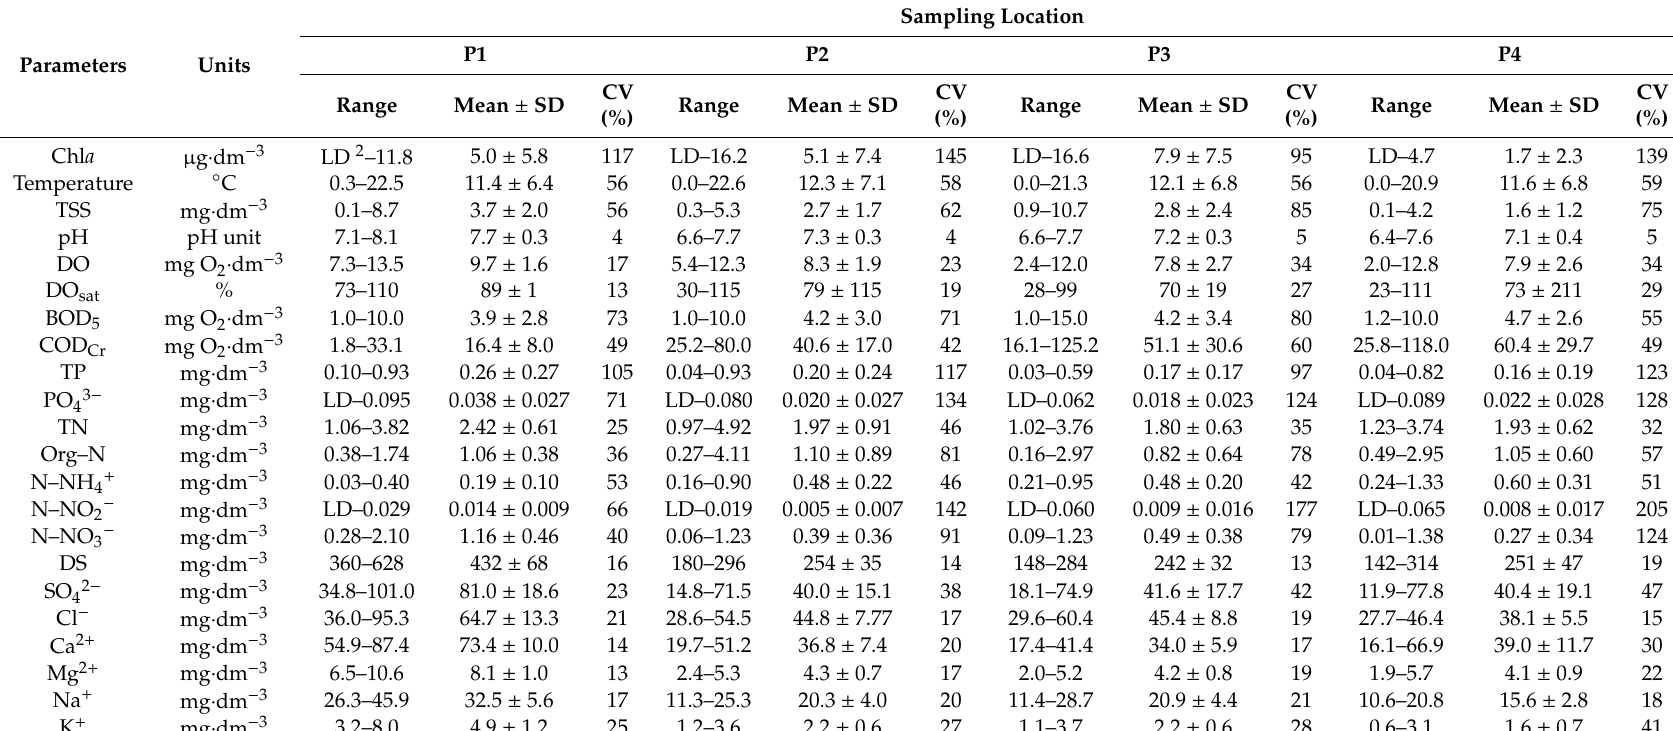
Table 2. Descriptive statistics of studied water quality parameters 1 at the monitoring sites during the research